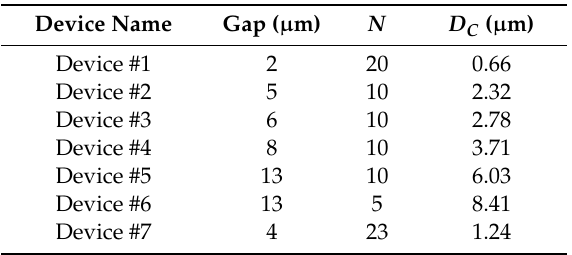
Table 1. Parameters of DLD devices used in this work. Critical diameters, D C , are nominal values based on the geometry of the pillar array (Equation